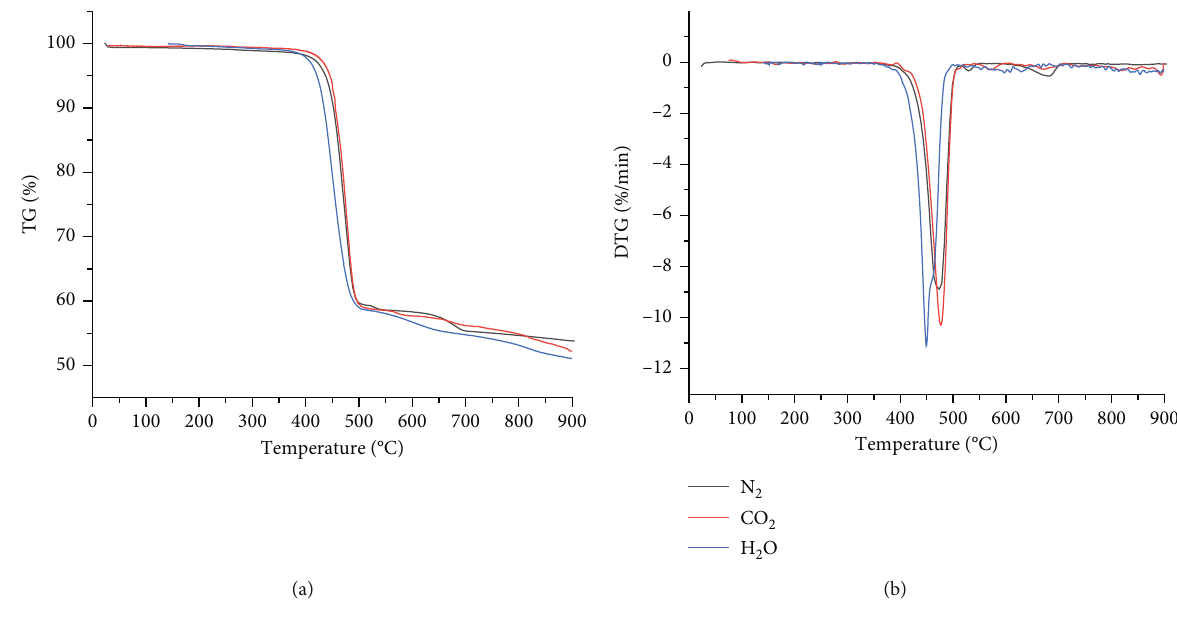
Figure 2: TG-DTG curves of JM in di ff erent